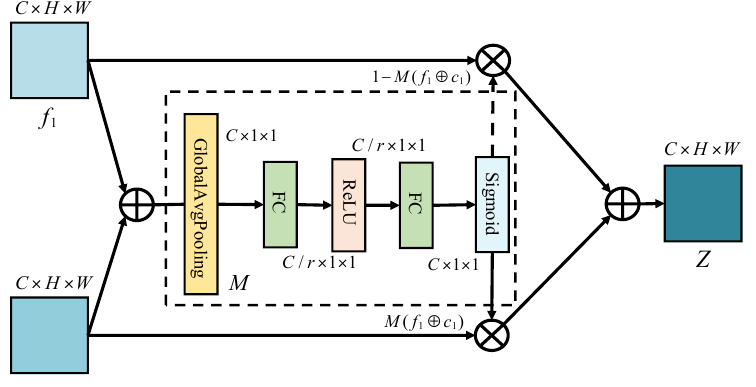
Figure 4. Structural diagram of AFF fusion module. f 1 and c 1 are two input features, C × H × W are represent the channel, height and width of the image, M ( f 1 ⊕ c 1 ) indicates the weight obtained by the channel focus module, ⊕ means that the elements are added directly, ⊗ means that the elements are